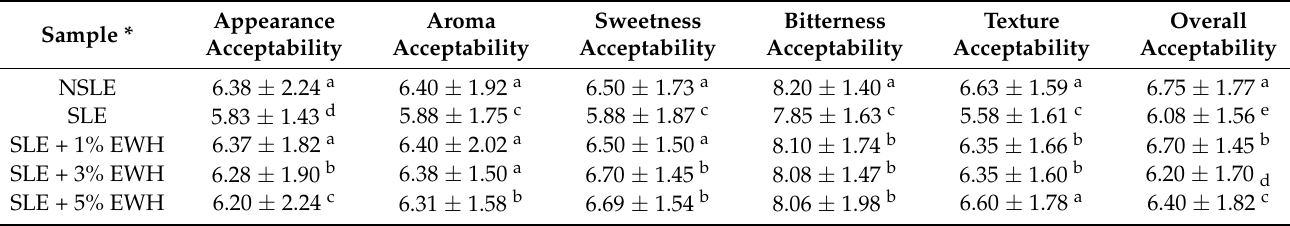
Table 3. Organoleptic analysis of cake made with non-sterilized liquid egg white (NSLE), sterilized liquid egg white (SLE), and SLE supplemented with 1%, 3%, or 5% egg white hydrolysate (EWH).